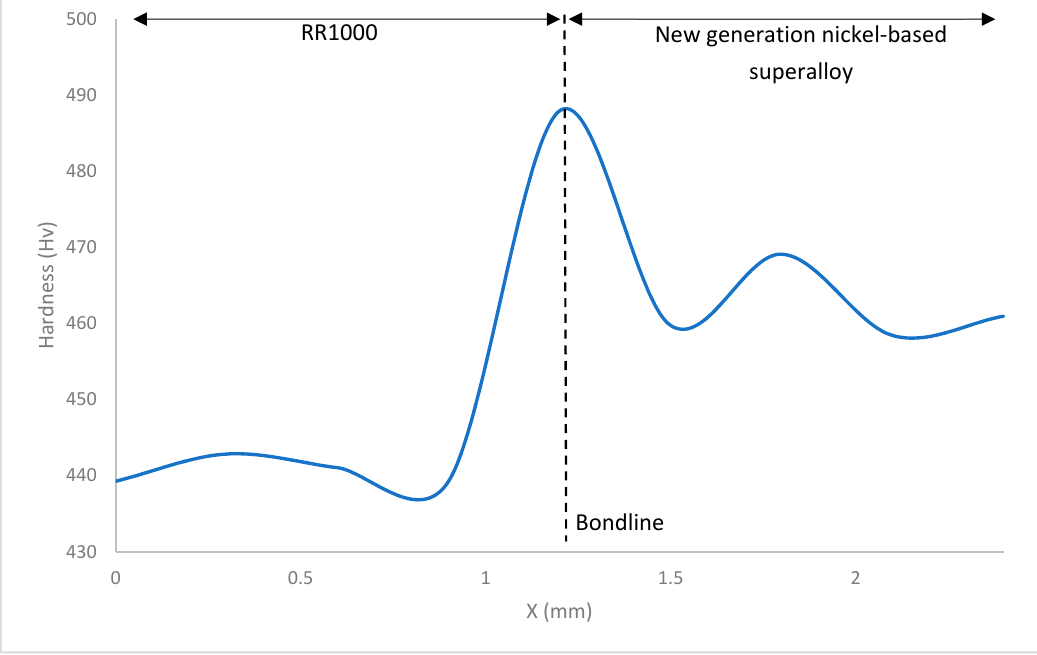
Figure 9. Graph detailing Vickers Hardness variation in bond 1 .